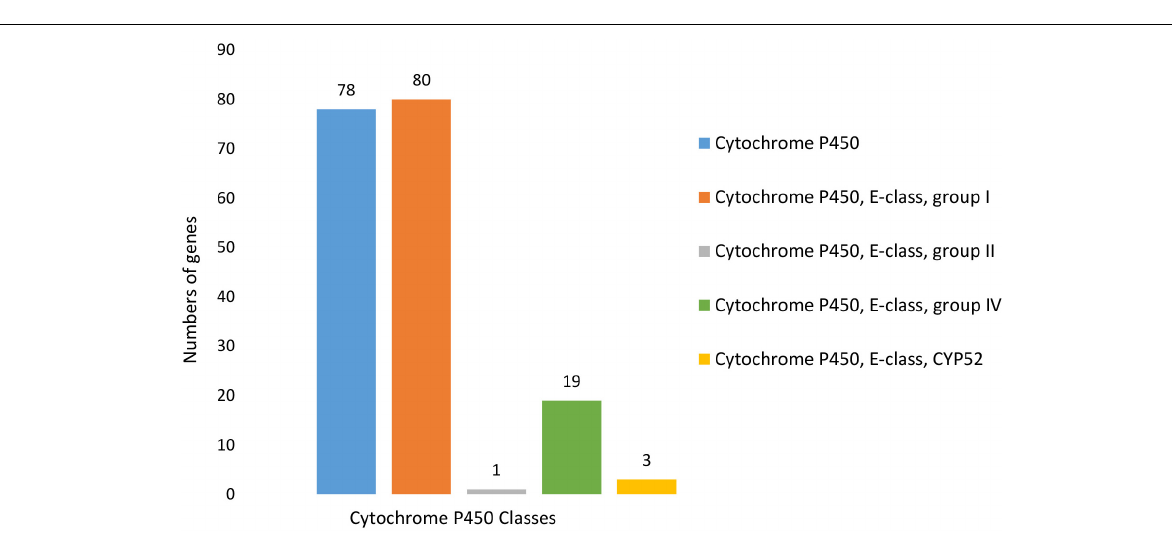
FIGURE 8 | Representation of Classified and Unclassified kinase families found in the MA3 genome. The families included the Protein kinase A, G and C families (AGC), Calcium and Calmodulin-regulated kinases (CAMK), Cell Kinase 1 (CK1), CMGC group (named after the initials of some members) including key kinases such as the MAPK growth- and stress-response kinases, the cell cycle CDK (cyclin dependent kinases) as well as kinases involved in splicing and metabolic control and STE (Yeast STE homologs).